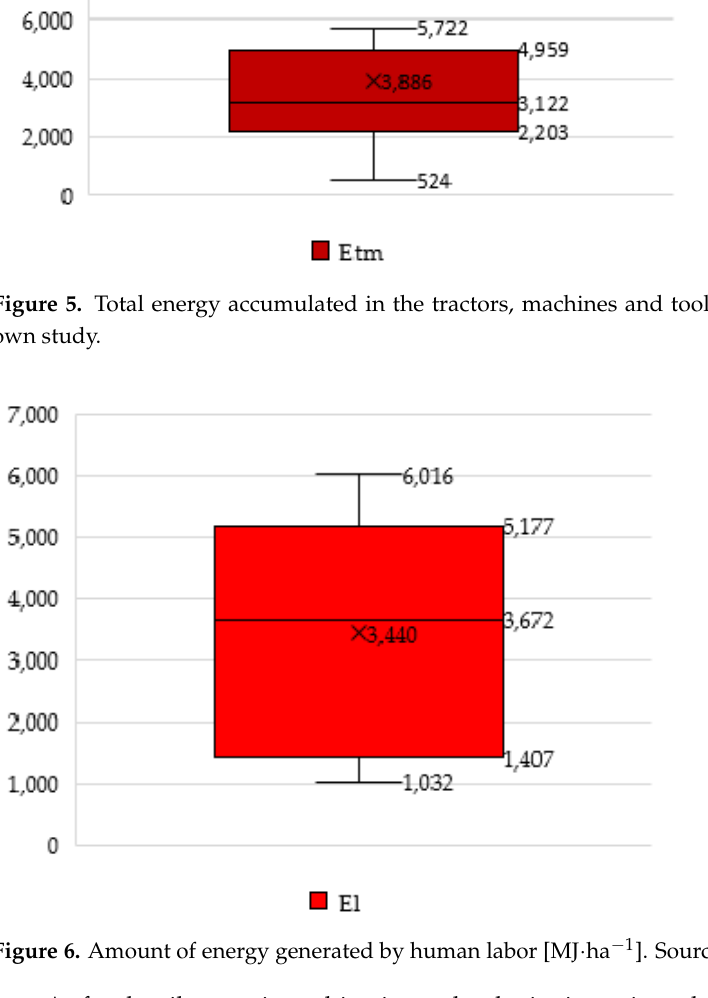
Figure 6. Amount of energy generated by human labor [MJ ∙ ha − 1 ]. Source: own study.